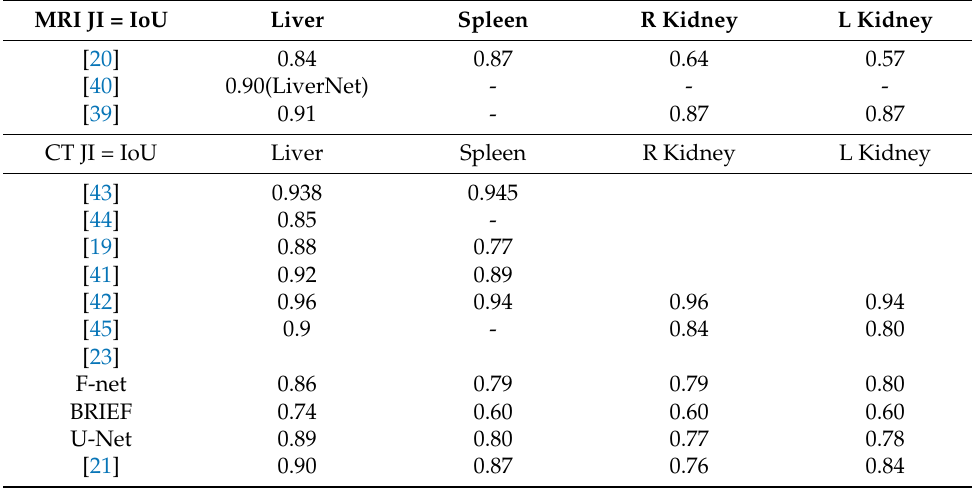
Table 8. IoU as reported in some related approaches (MRI and